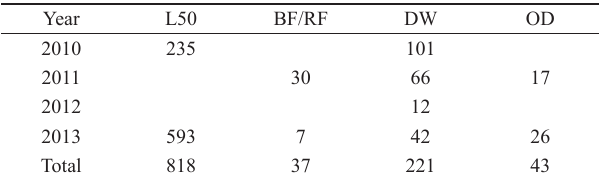
Tab. 2. Number of Pagrus pagrus individuals per year used for estimations of length at first maturity (L50), batch and relative fecundity (BF/RF), hydrated oocytes dry weight (DW) and diameter (OD).